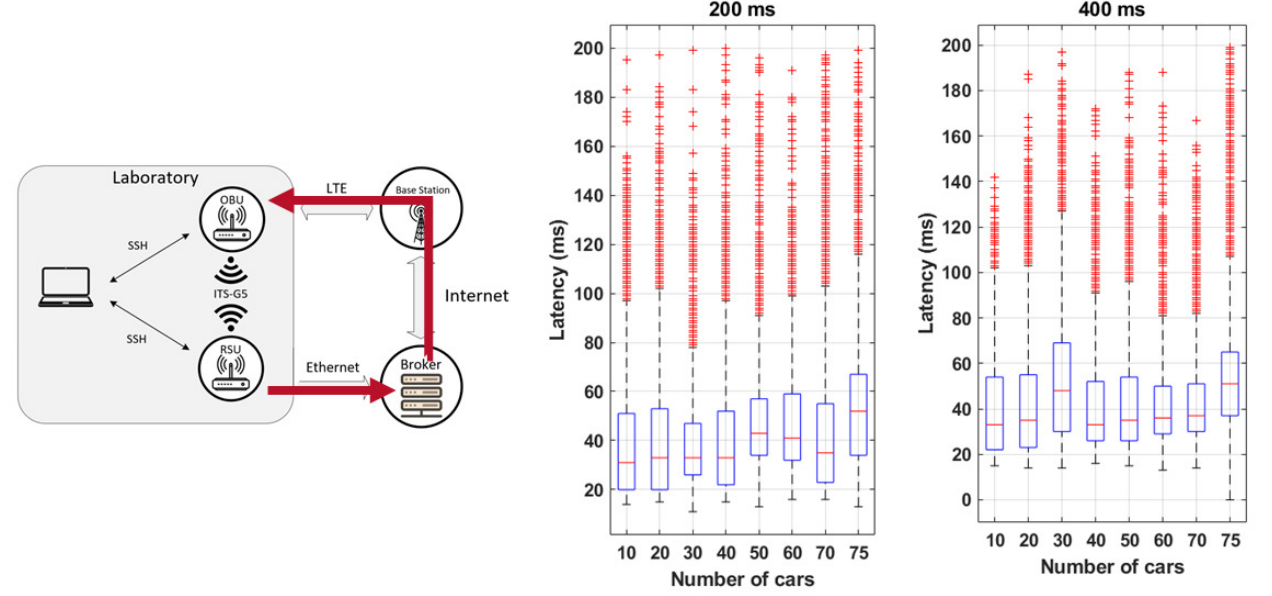
Figure 19. Latency values for 200 ms and 400 ms dissemination intervals using Ethernet + LTE technologies.